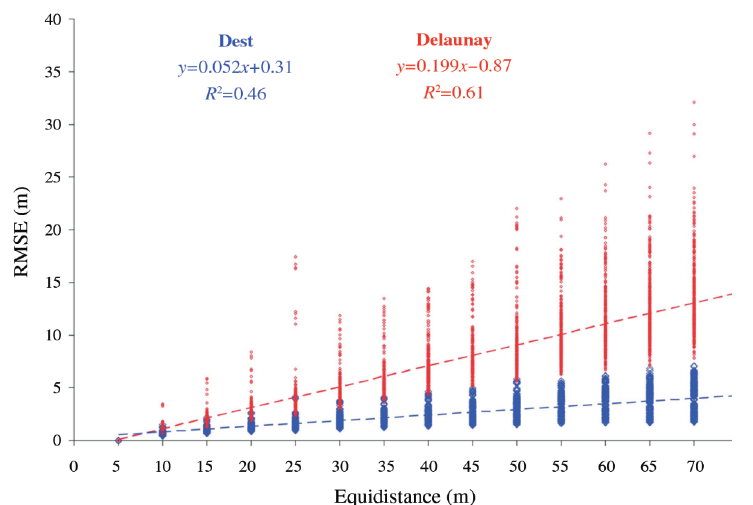
Fig. 3. Plot of RMSE versus equidistance computed through the DEST (open blue diamond) and Delaunay ap- proach (open red diamond). The original equidistance was ∆ z 0 = 5 m. The regression line slope represents the av- erage errors in interpolation as a function of equidistance. DEST has an average RMSE of about 5% of the equidistance, whereas Delaunay has an average RMSE of